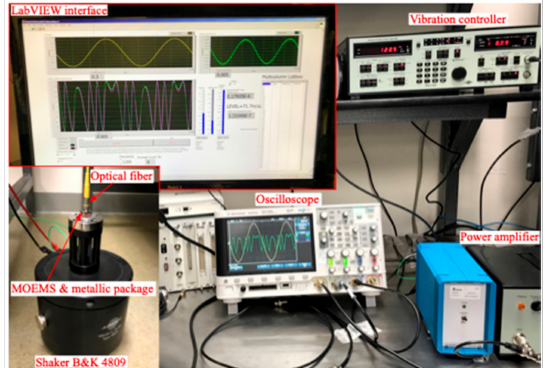
Figure 12. Electronic setup showing the vibration controller, oscilloscope, power amplifier, metallic package mounted on the shaker, the connector of the optical fiber (yellow), and the LabVIEW interface for the data collection and